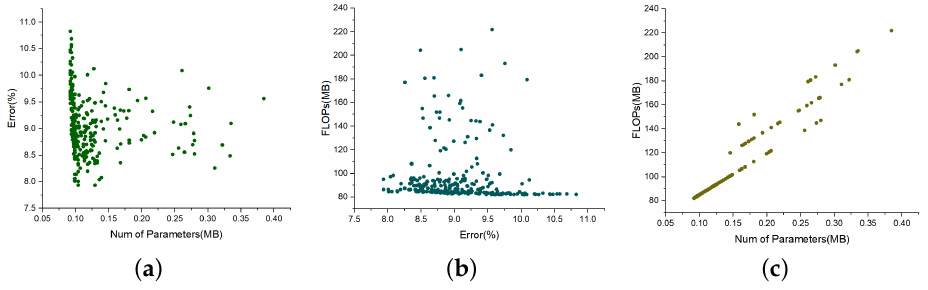
Figure 5. The pairwise relationships of three objectives on dataset OPPORTUNITY. ( a ) Change relation between number of parameters and error. ( b ) Change relation between error and FLOPs. ( c ) Change relation between number of parameters and